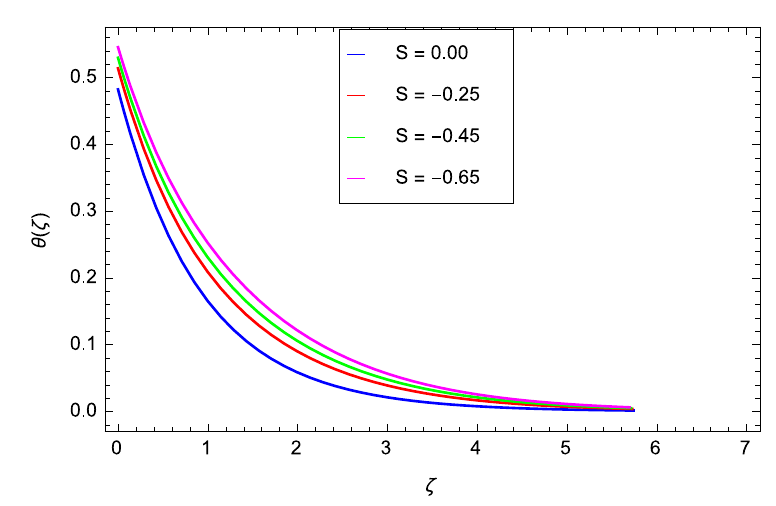
Figure 10. Influence of S < 0 on θ ( ζ ) .